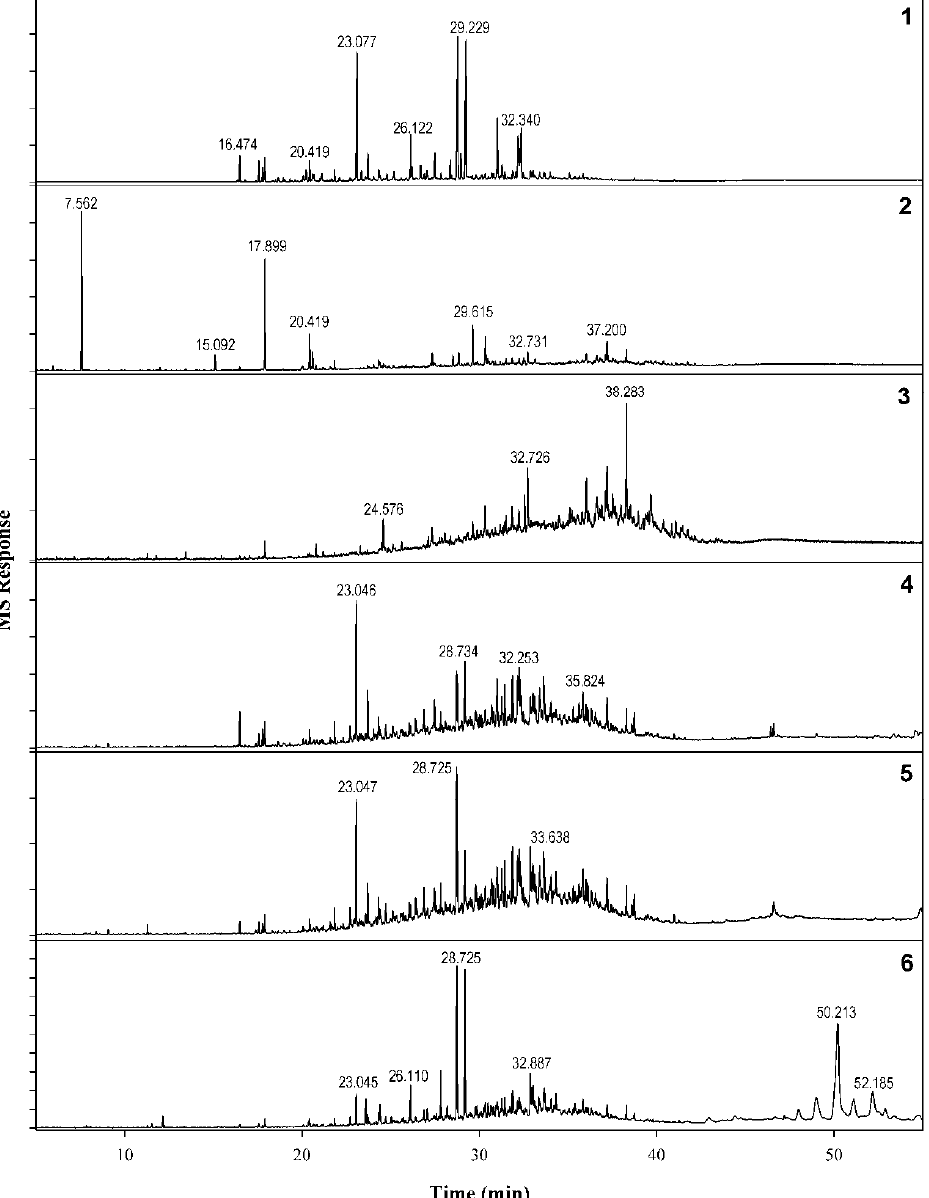
Figure 7. Comparative GC-MS profiles of various samples of C. myrrha . Specimens: (1) #3550, (2) #2092, (3) #5369, (4) #6452, (5) #8549, and (6)